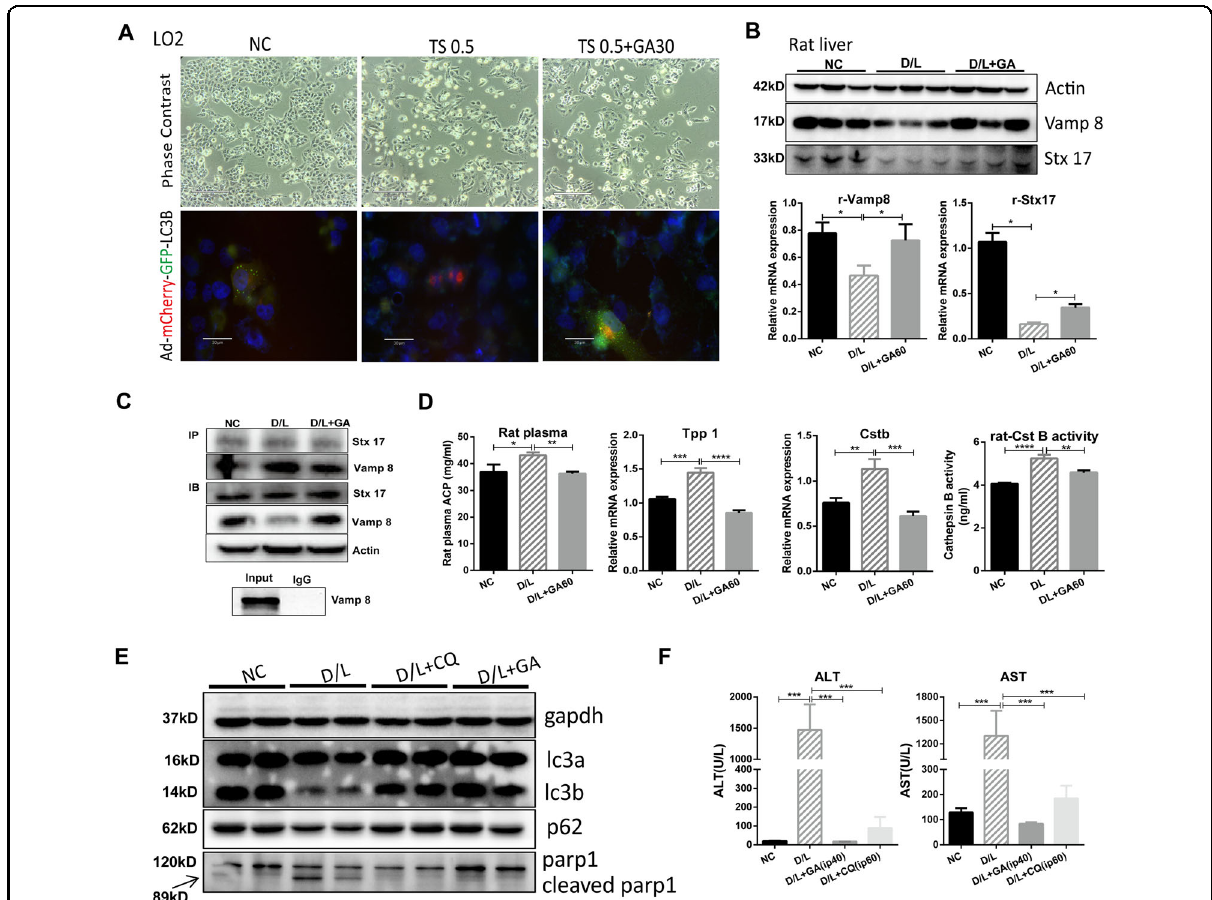
Fig. 3 Effect of GA on autophagosome – lysosome fusion and degradation. LO2 cells were transfected with GFP-mCherry-LC3 for 24 h, and treated with TS (0.5 μ l/ml) and/or GA (30 μ M) for 24 h, the fl uorescence images were captured by microscopy, scale bar = 30 μ m ( A ). The lysosome and autophagosome markers Vamp 8 and Stx17 protein levels were detected by western blot and RT-PCR ( B ), their interactions were detected by co- immunoprecipitated ( C ) and effect of GA on lysosomal integrity were measured ( D ) in rat liver. C57bl/6 mice ( n = 8) cotreated D/L with or without CQ (60 mg/kg) or GA (40 mg/kg) for 5 days ( n = 8), and the expression of LC3-B, P62 and cleaved Parp1 ( E ), ALT and AST ( F ) were measured. Data are shown as mean ± SD, statistical signi fi cance: * P < 0.05, ** P < 0.01, *** P <